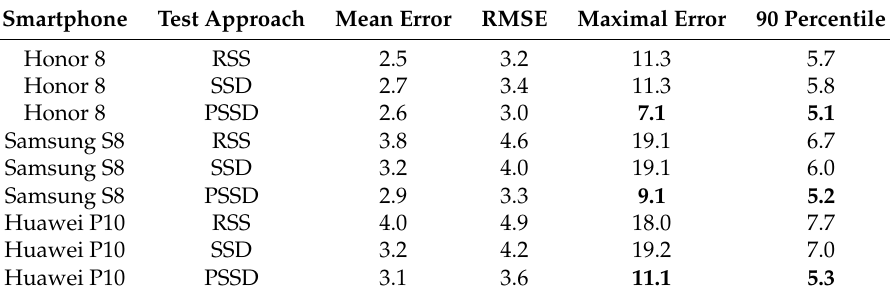
Figure 13. Localization performance in terms of fingerprints collected by Honor 8. ( a ) Comparisons of three approaches using the Honor 8 in online phase. ( b ) Comparisons of three approaches using the Samsung S8 at online phase. ( c ) Performance of the RSS approach using different devices. ( d ) Performance of the PSSD approach using different devices. Table 3. Statistics of localization performance. The unit is